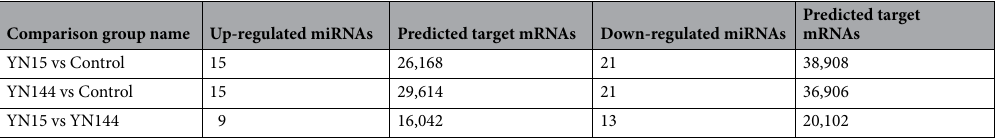
Table 1. Number of DE miRNAs and their target mRNAs. Table shows the numbers of up-regulated miRNA and down-regulated miRNA, and their target mRNAs in each of the three comparison groups, respectively.